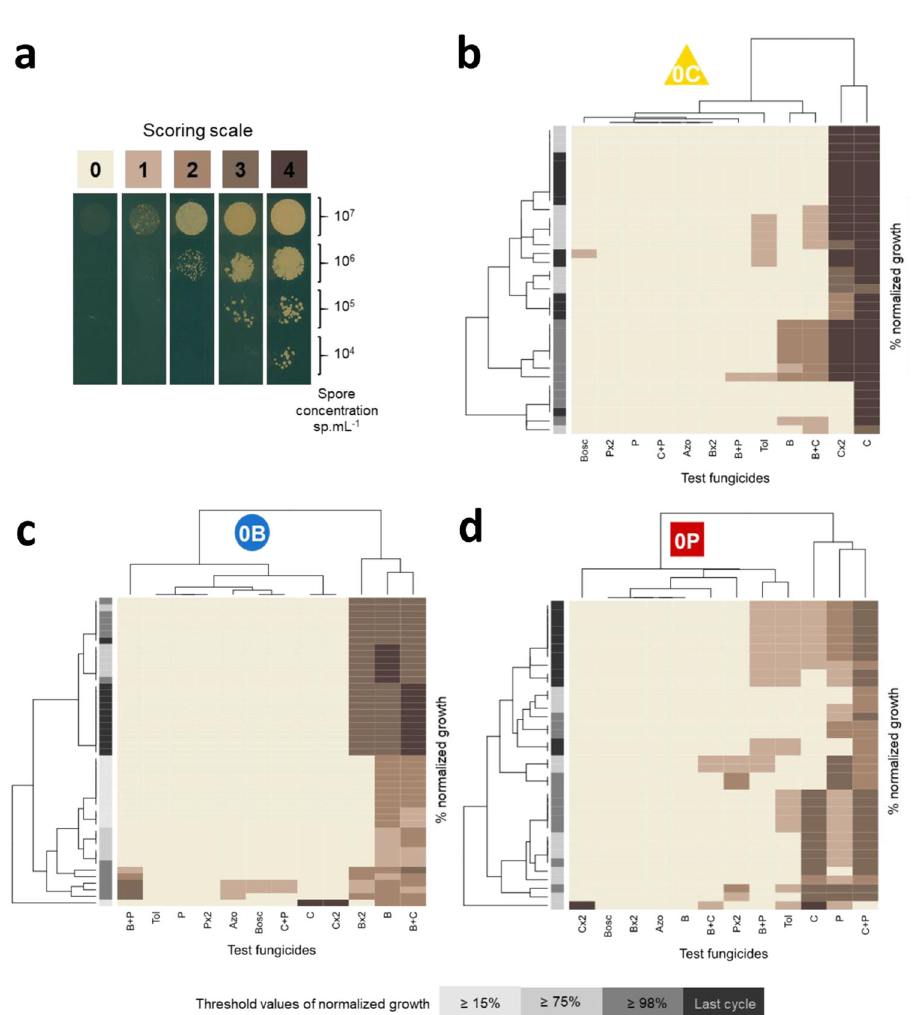
Fig. 3 Evolution of phenotype resistance pro fi les during experimental evolution. a Scoring scale was used to assess the growth of isolates on a solid medium supplemented with discriminatory doses of fungicides (droplet tests). For each isolate, four spore concentrations were tested on the same plate. 0: no growth (susceptible isolate). 1 – 4: growth varying with spore concentration (resistant isolate). The fungicides tested included B, C, and P at their selection doses, at twice this dose, and in mixtures, as well as fungicides not used in the experiment (boscalid, azoxystrobin, tolnaftate). Tolnaftate was used to identify isolates displaying multidrug resistance due to enhanced ef fl ux. b – d Heatmaps of phenotype resistance pro fi les scored for isolates collected during experimental evolution, and for lines continuously exposed to C, B, and P, respectively. For each line and fungicide test, the resistance rating scores (0 – 4; represented by the brown scale) of 12 isolates collected from the four replicates are shown for three to four critical values of spore concentration in lines subjected to alternating regimes relative to control lines ( ≥ 15% fi nal frequency; represented by the gray scale). The structure of the lines under continuous B, C, or P selection revealed signi fi cant changes between these different stages of resistance evolution (AMOVA; 0.273 < F st < 0.453; P <